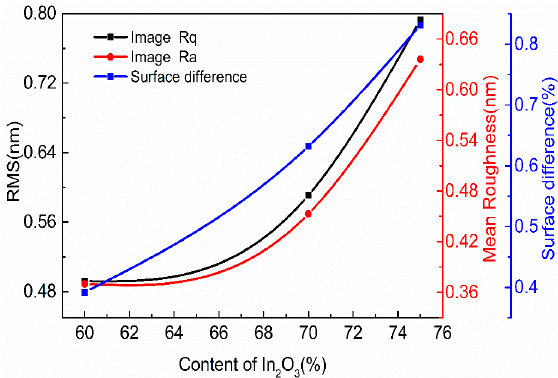
Figure 7. Change of square root mean roughness of InGaZnO film with the doping ratio of In 2 O 3 .